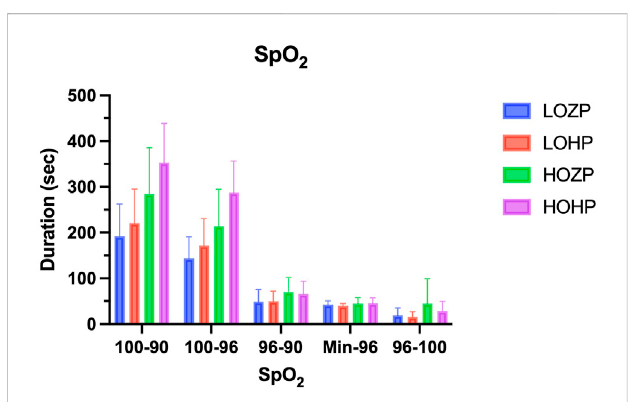
FIGURE 2 The non-hypoxemic apnea time after induction and the rising time of the SpO 2 after ventilation resume. The non-hypoxemic apnea time (T 100-90 andT 100-96 )wassigni fi cantly longer inthegroup ofHOHPwhen compared to the other three groups ( p < .01). The rising time of the SpO 2 did not differ among the groups ( p >